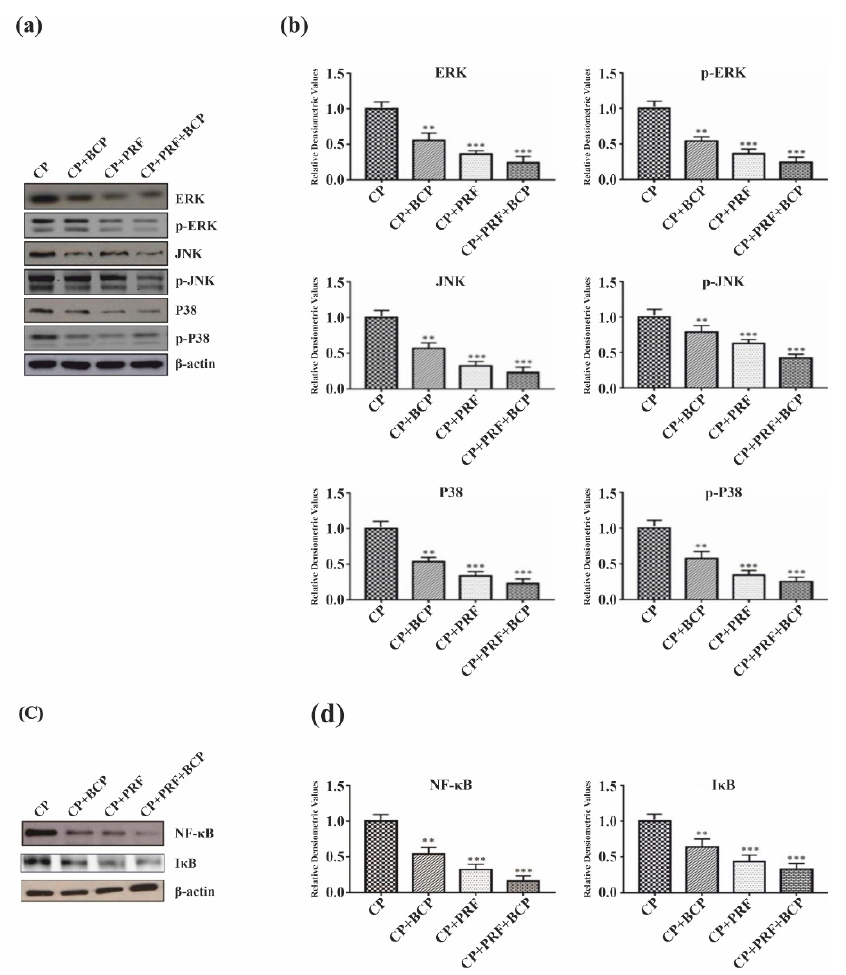
Figure 3. Effect of PRF/BCP on MAPK / NF-kB pathway. Western blot analysis of MAPK molecules ( ERK, p-ERK , JNK , p- JNK and P38, p-P38 ) were blotted and normalized with β -actin. ( a ) Repre- sentative blot image. ( b ) Relative densitometric analysis in histograms. NF-kB and IKB molecules were blotted and normalized with β -actin. ( c ) Representative blot image. ( d ) Relative densitometric analysis in histograms. Results are presented by mean ± SD. Comparisons were made among